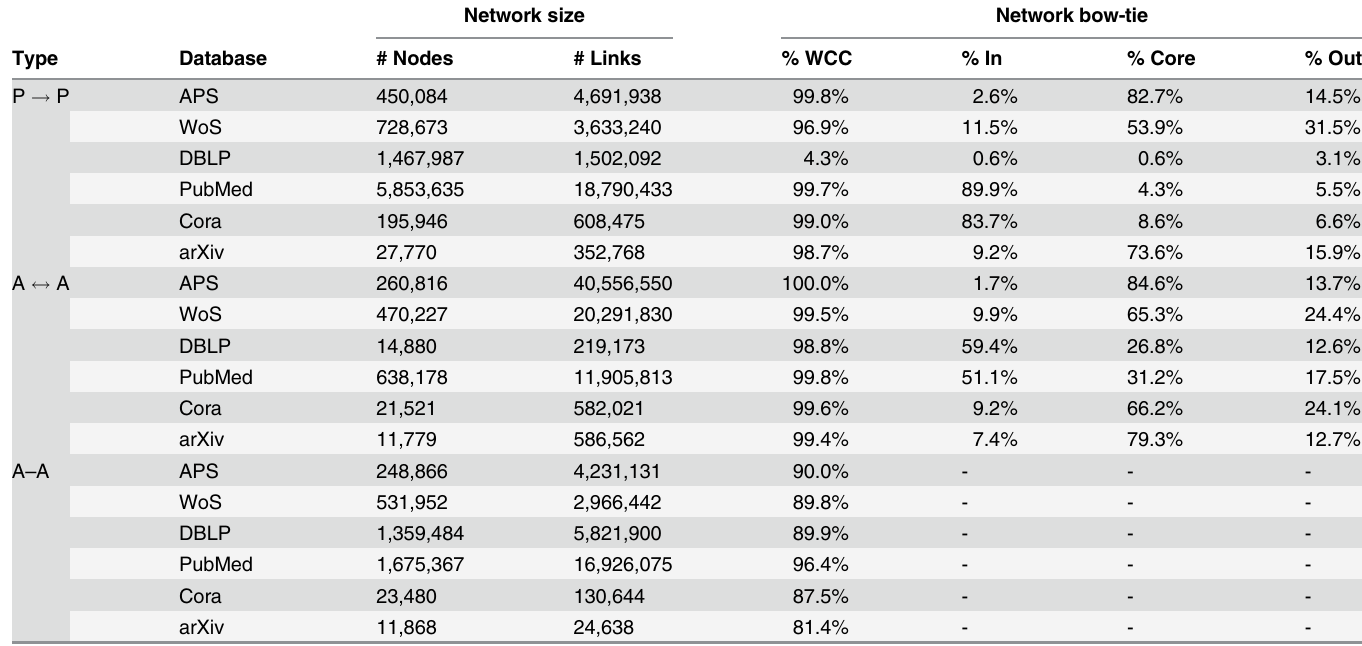
Table 1. Basic network measures. The values of all basic network measures for the 18 examined networks. See Methods for details on the definitions of network measures and their